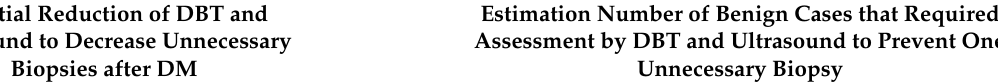
Table 4. The potential reduction of DBT and ultrasound to decrease unnecessary biopsies following screening mammography and the number of DBT and ultrasound examinations required to be assessed to prevent one unnecessary